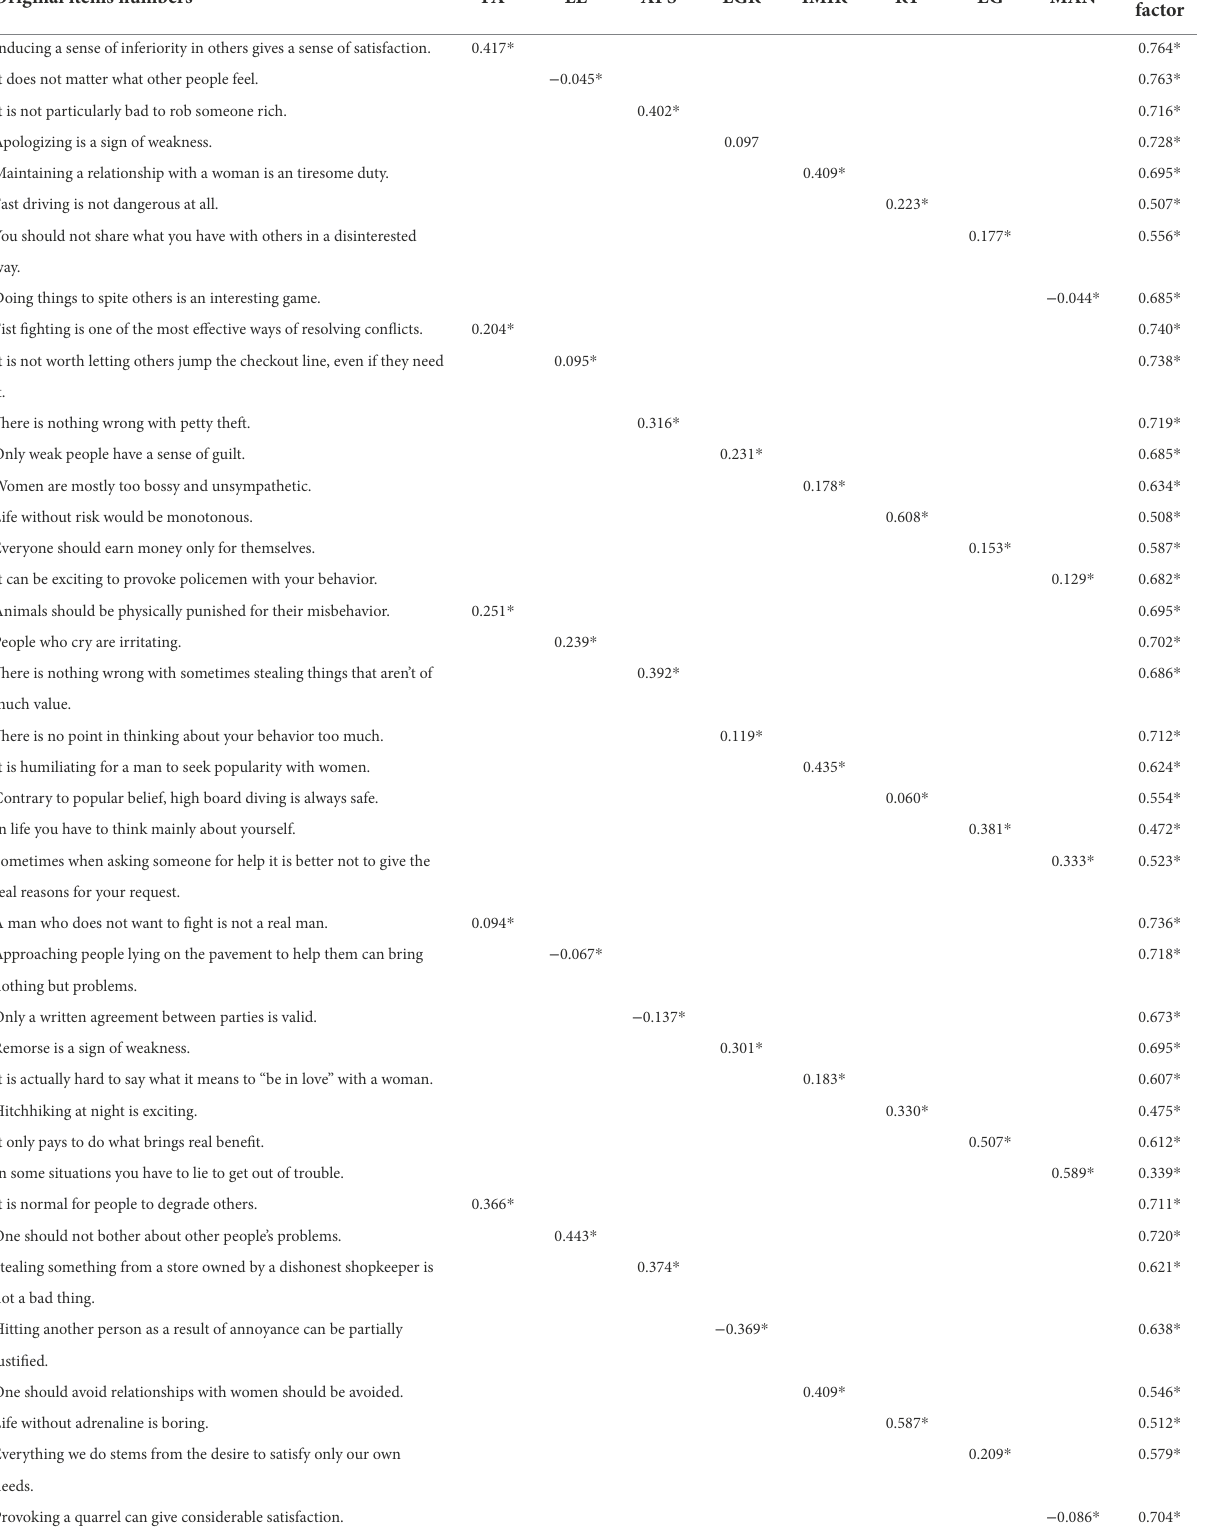
TABLE 5 Standardized factor loadings for the general factor and the factors representing eight antisocial beliefs. Original items numbers